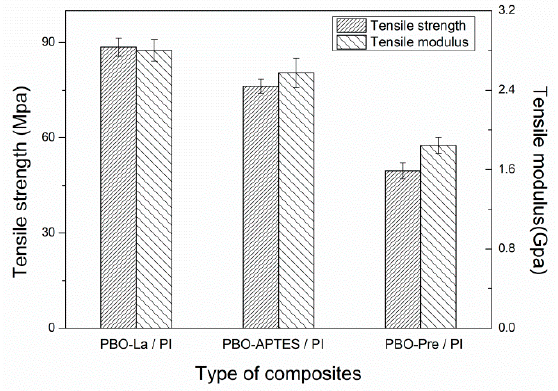
Figure 9. The tensile properties of the three composites at room temperature.